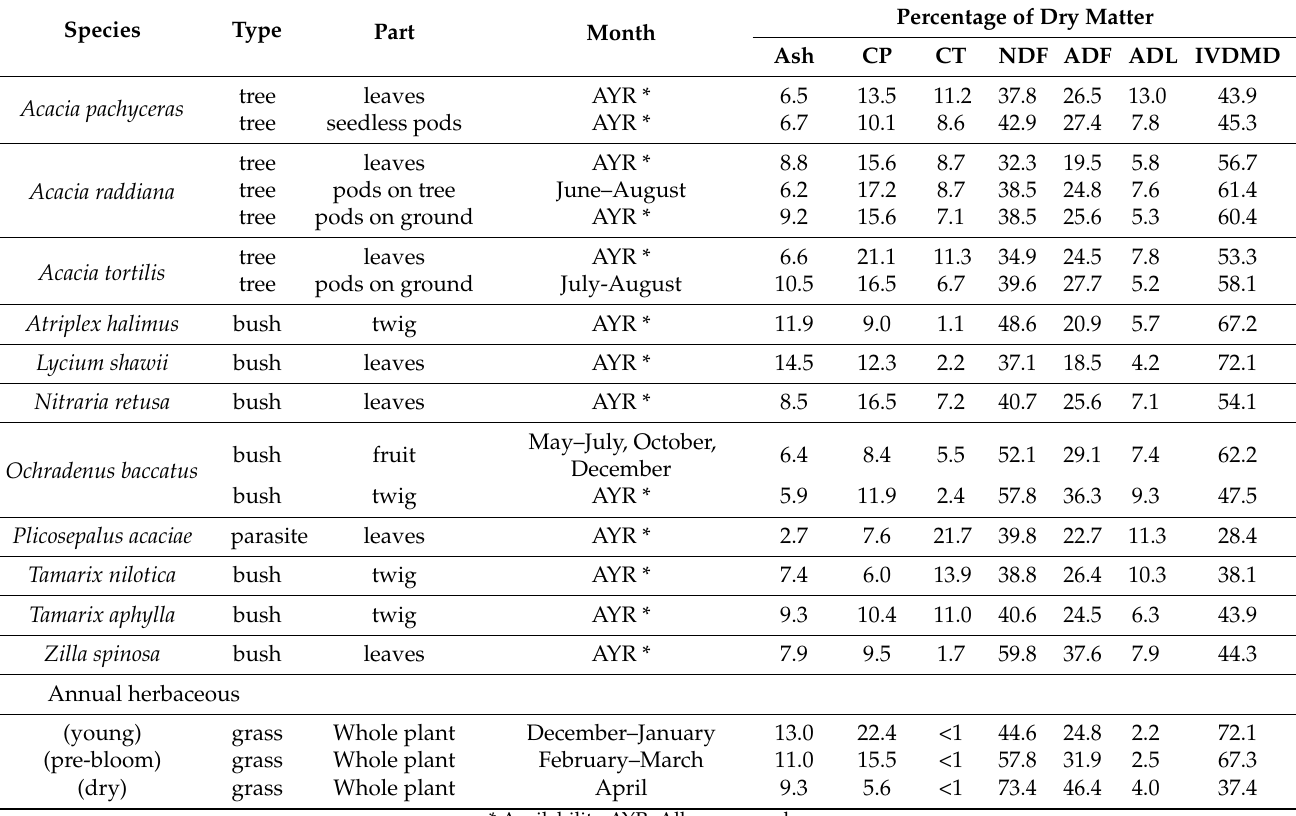
Table 2. The contents (% of dry matter) of ash, crude protein (CP), condensed tannins (CT), neutral detergent fiber (NDF), acid detergent fiber (ADF), lignin (ADL), and the dry matter in vitro digestibility of plants collected in the Arava and Paran release